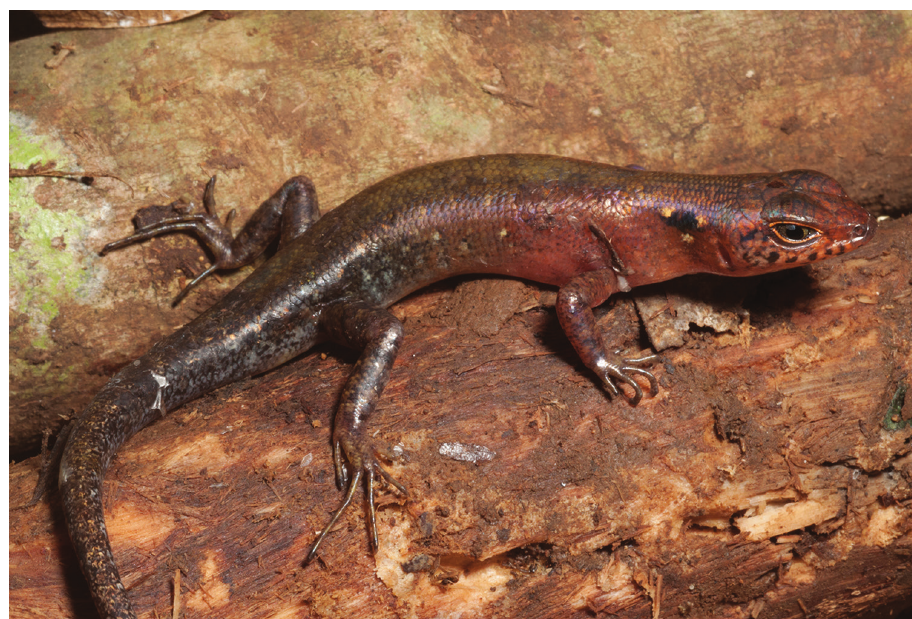
Figure 61. Sphenomorphus variegatus (KU 334312) from Mt. Hilong-hilong, Municipality of Remedios T. Romualdez, Agusan del Norte Province. Photo: